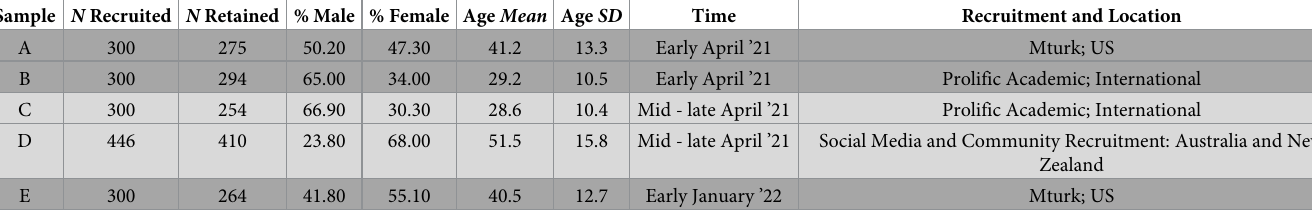
Table 1. Participant characteristics by